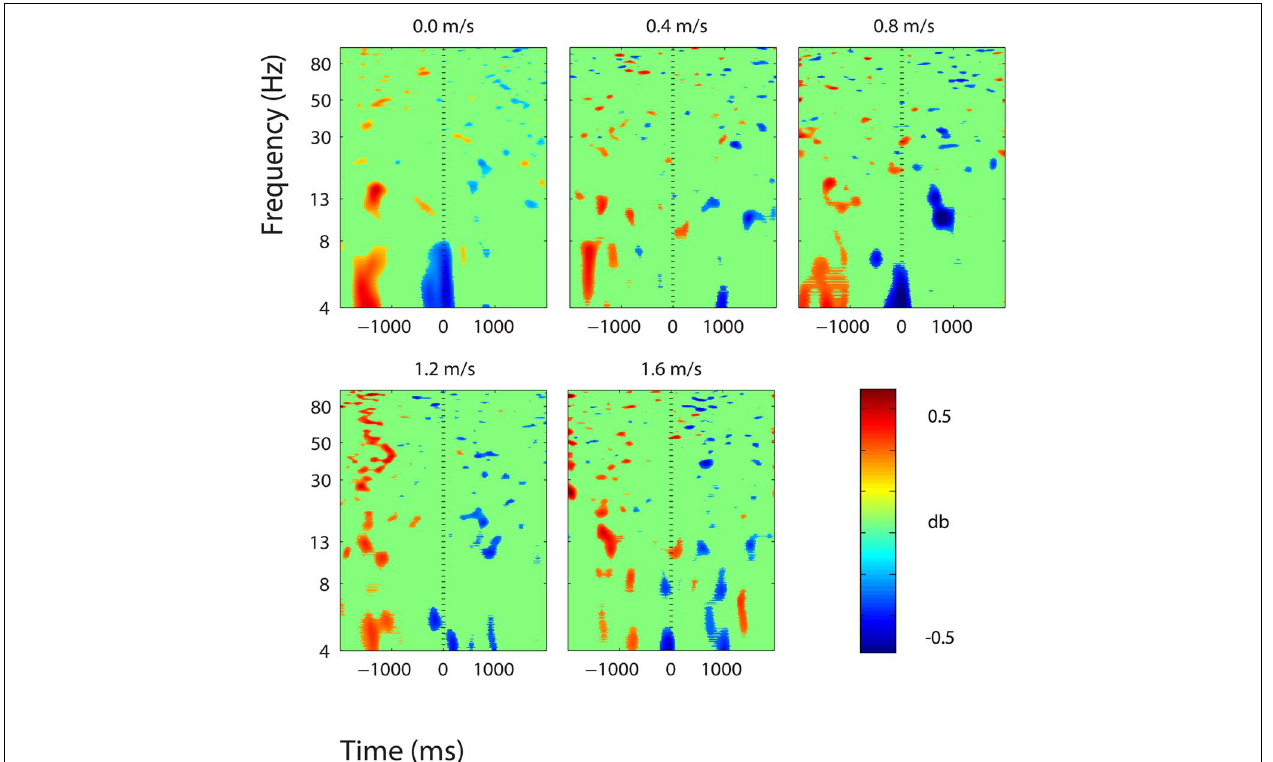
FIGURE 10 | Event-related spectral perturbation plots showing power change around the presentation of a stimulus (a digit and its position in an imagined grid) in the posterior cingulate cortex (BA 31). Red represents a power increase from baseline and